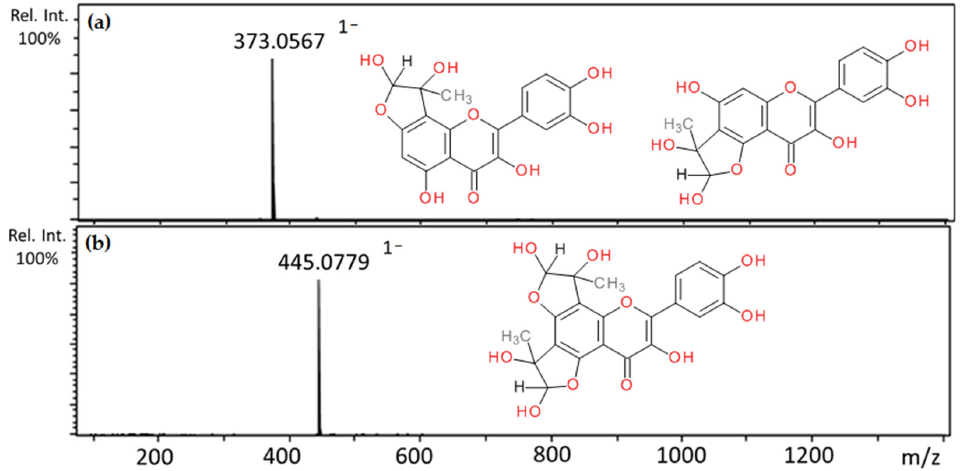
Figure 8. Mass spectra of methylglyoxal adducts with quercetin after 1 h incubation in pH 7.4 phosphate buffer solution at 37 ◦ C and their proposed chemical structure: ( a ) mono-MGO-quercetin; ( b ) di-MGO-quercetin; other isomeric forms are also possible.